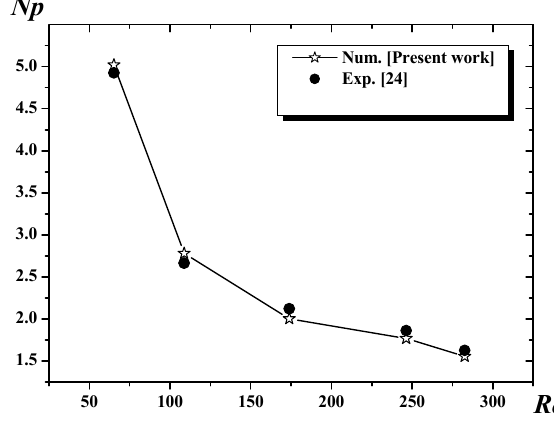
Figure 3. Power number for n = 0.4.